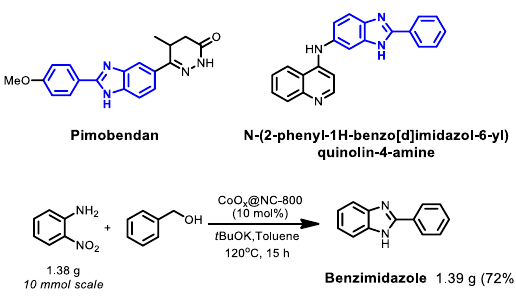
Scheme 2. Gram-scale synthesis of benzimidazoles under standard conditions.